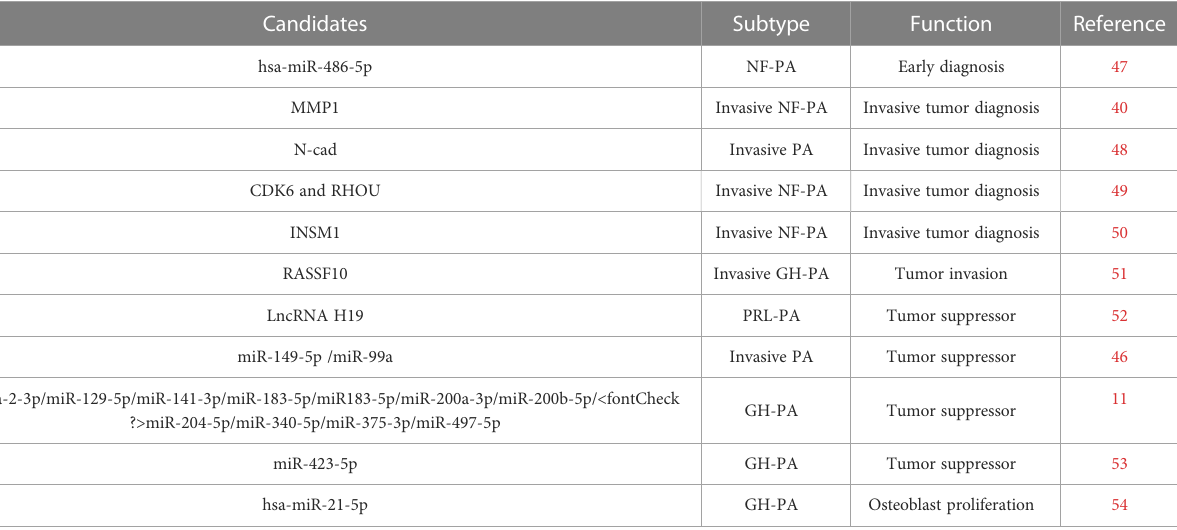
TABLE 1 Biological functions of exosomal RNAs in PA.